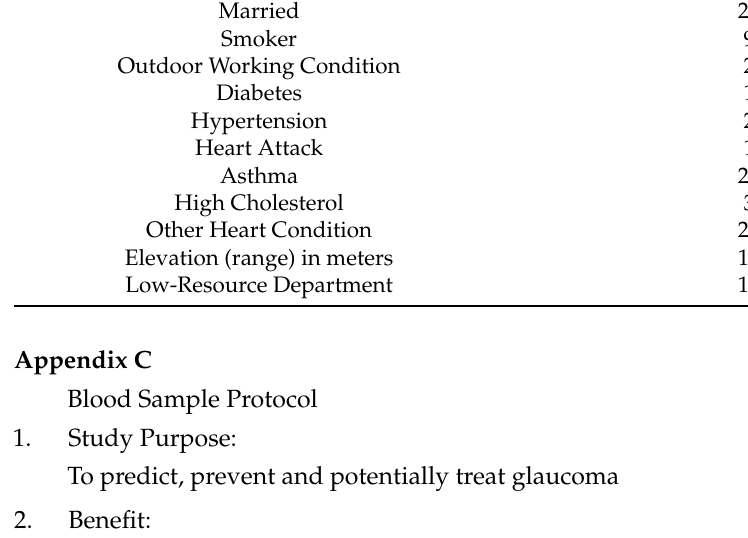
Table A1. Missing values that were imputed for univariate/multivariate epidemiological analysis. Demographic # of Missing Values Imputed Married 28 Smoker 9 Outdoor Working